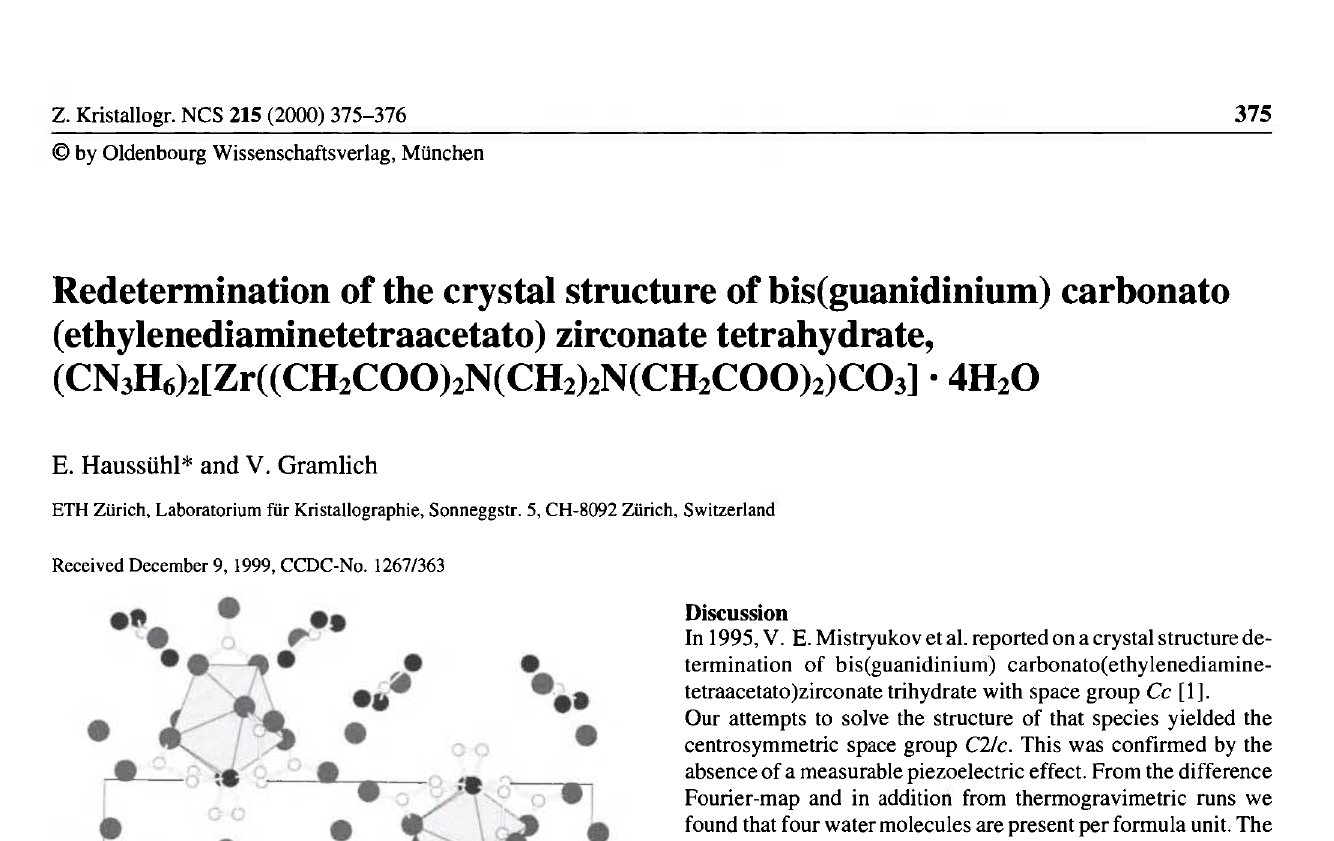
Table 1. Data collection and handling.